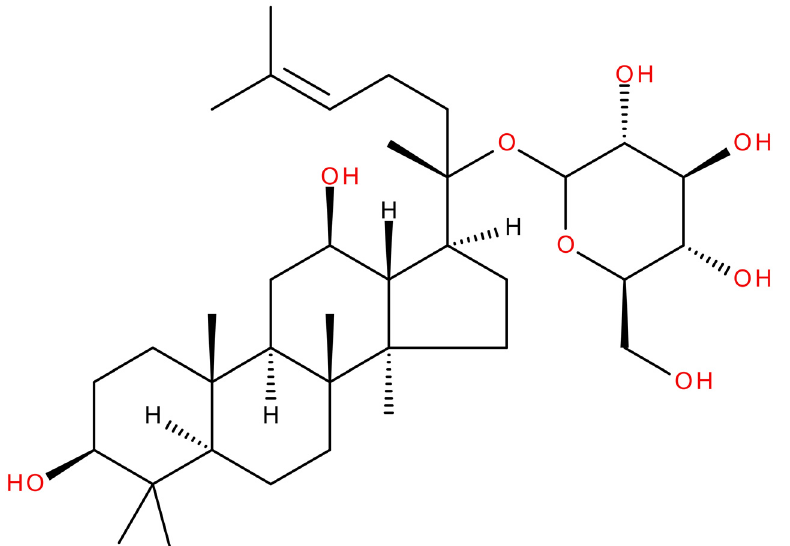
Fig 1. The molecular structure of